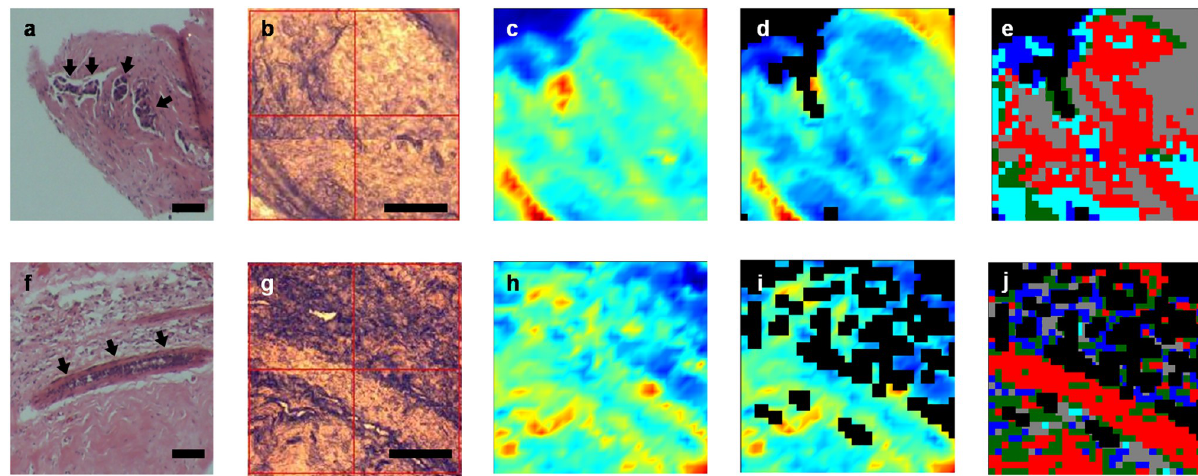
Fig 1. Schematic illustration of spectral pre-processing of tissue before (top) and after (bottom) chemotherapy. Presented: (a,f) microscopic images of H&E stained sections, scale bars: 100 μ m; (b,g) OPUS images, scale bars: 100 μ m; (c,h) FTIR chemical images of protein distribution using integrated area under amide I band (1710–1600 cm − 1 ); (d,i) denoised and quality-tested FTIR chemical images; (e,j) corresponding hierarchical cluster analysis images. Spectra for further analysis were chosen based on acquired HCA maps–cluster corresponding to selected ROI were included into final PCA